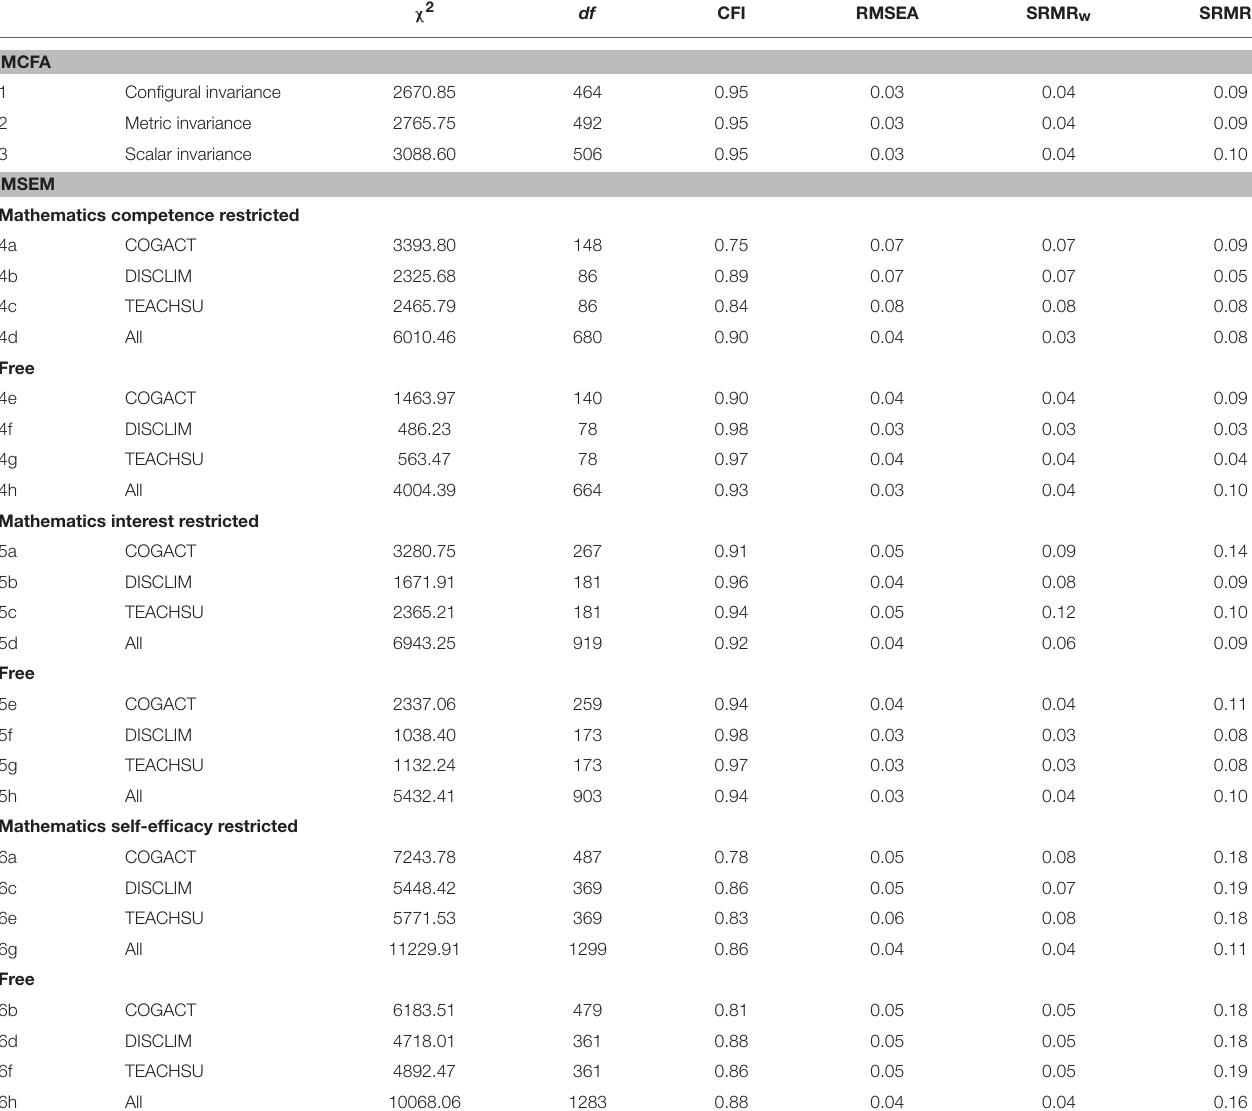
TABLE 3 | Summary of fit indices of multilevel confirmatory factor analyses (MCFA) and multilevel structural equation modeling (MSEM). χ 2 df CFI RMSEA SRMR w SRMR